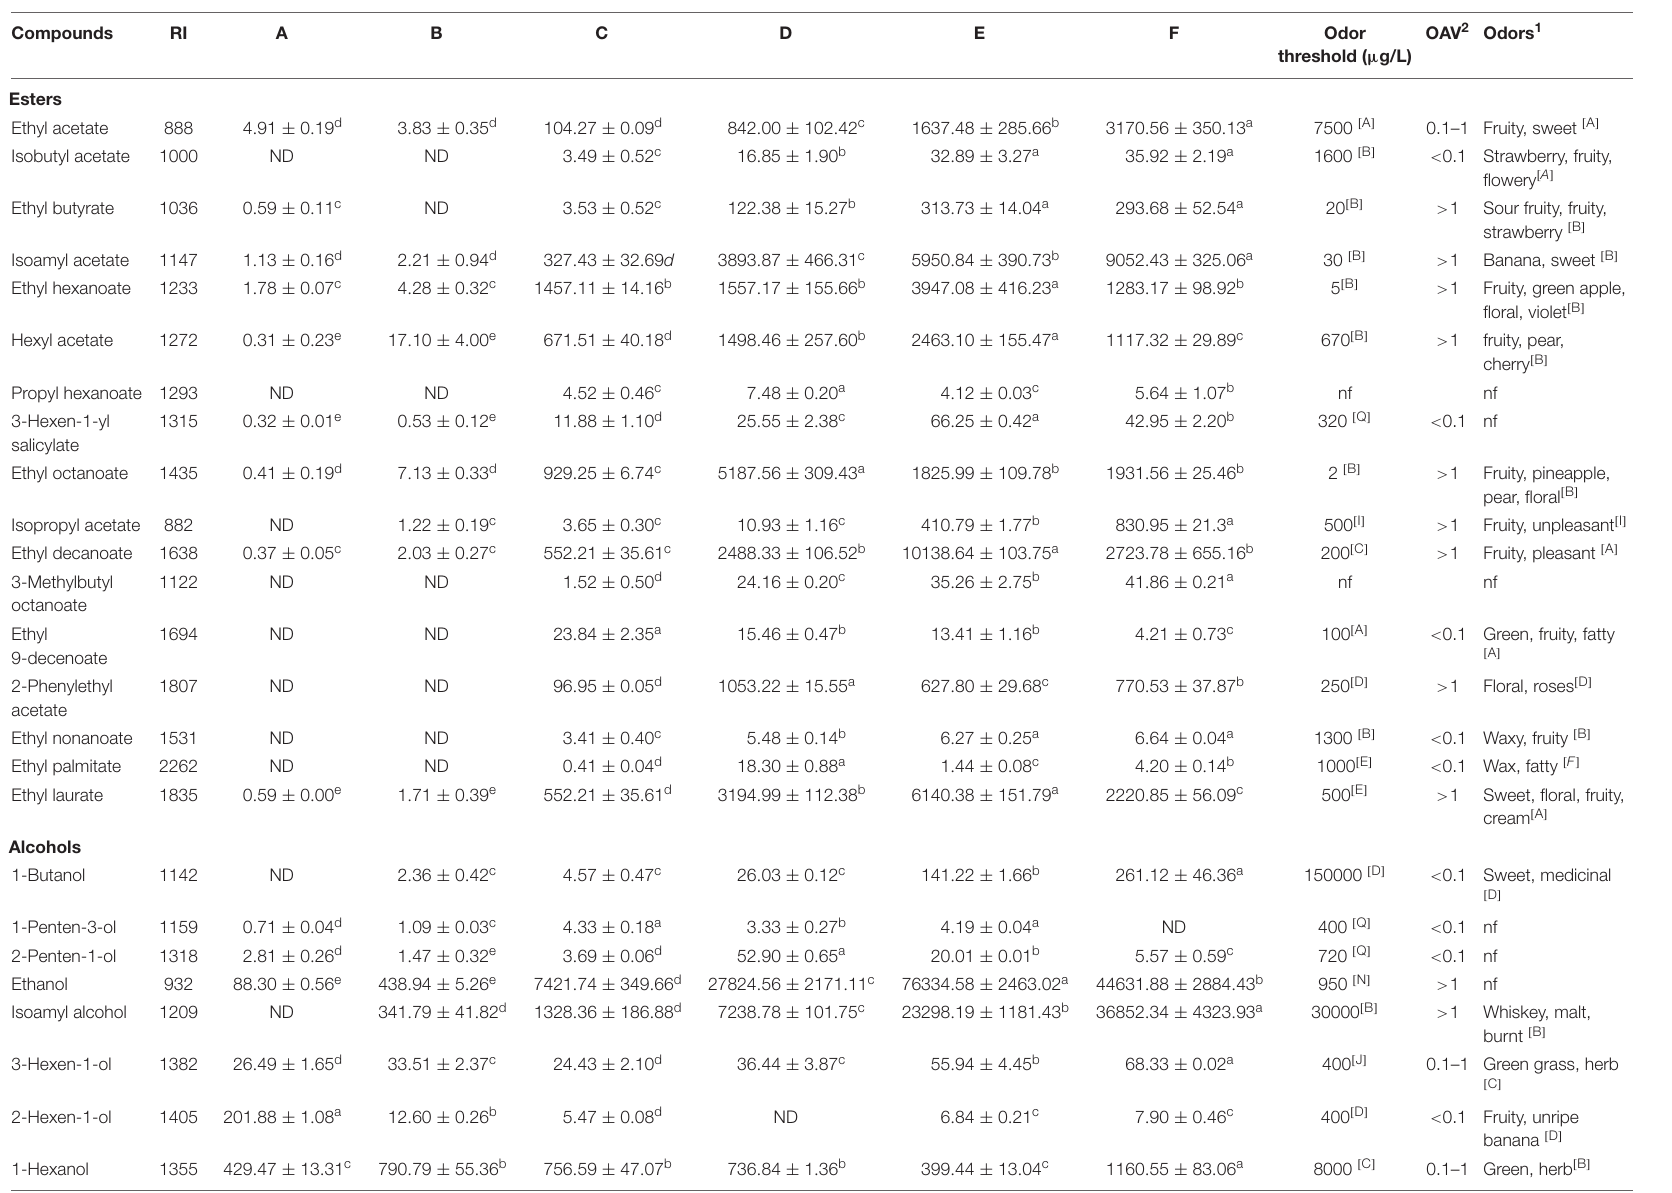
TABLE 2 | Dynamic changes of flavor compound content during Petit Manseng fermentation process ( µ g/L).